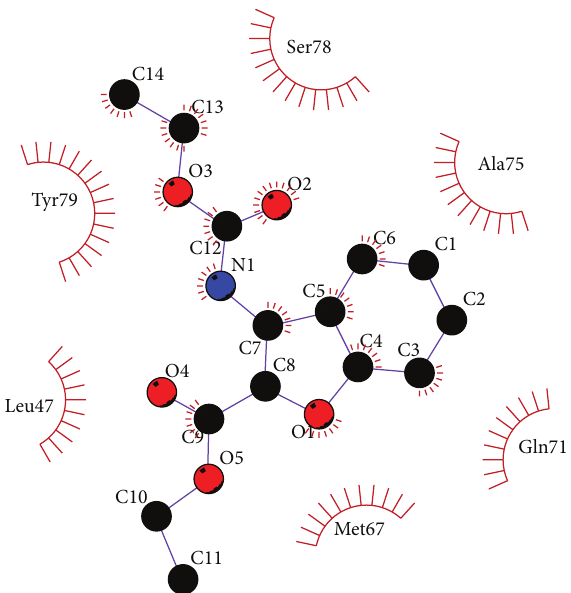
Figure 10: Interaction of C7 in the active site of NarL after molecular dynamic